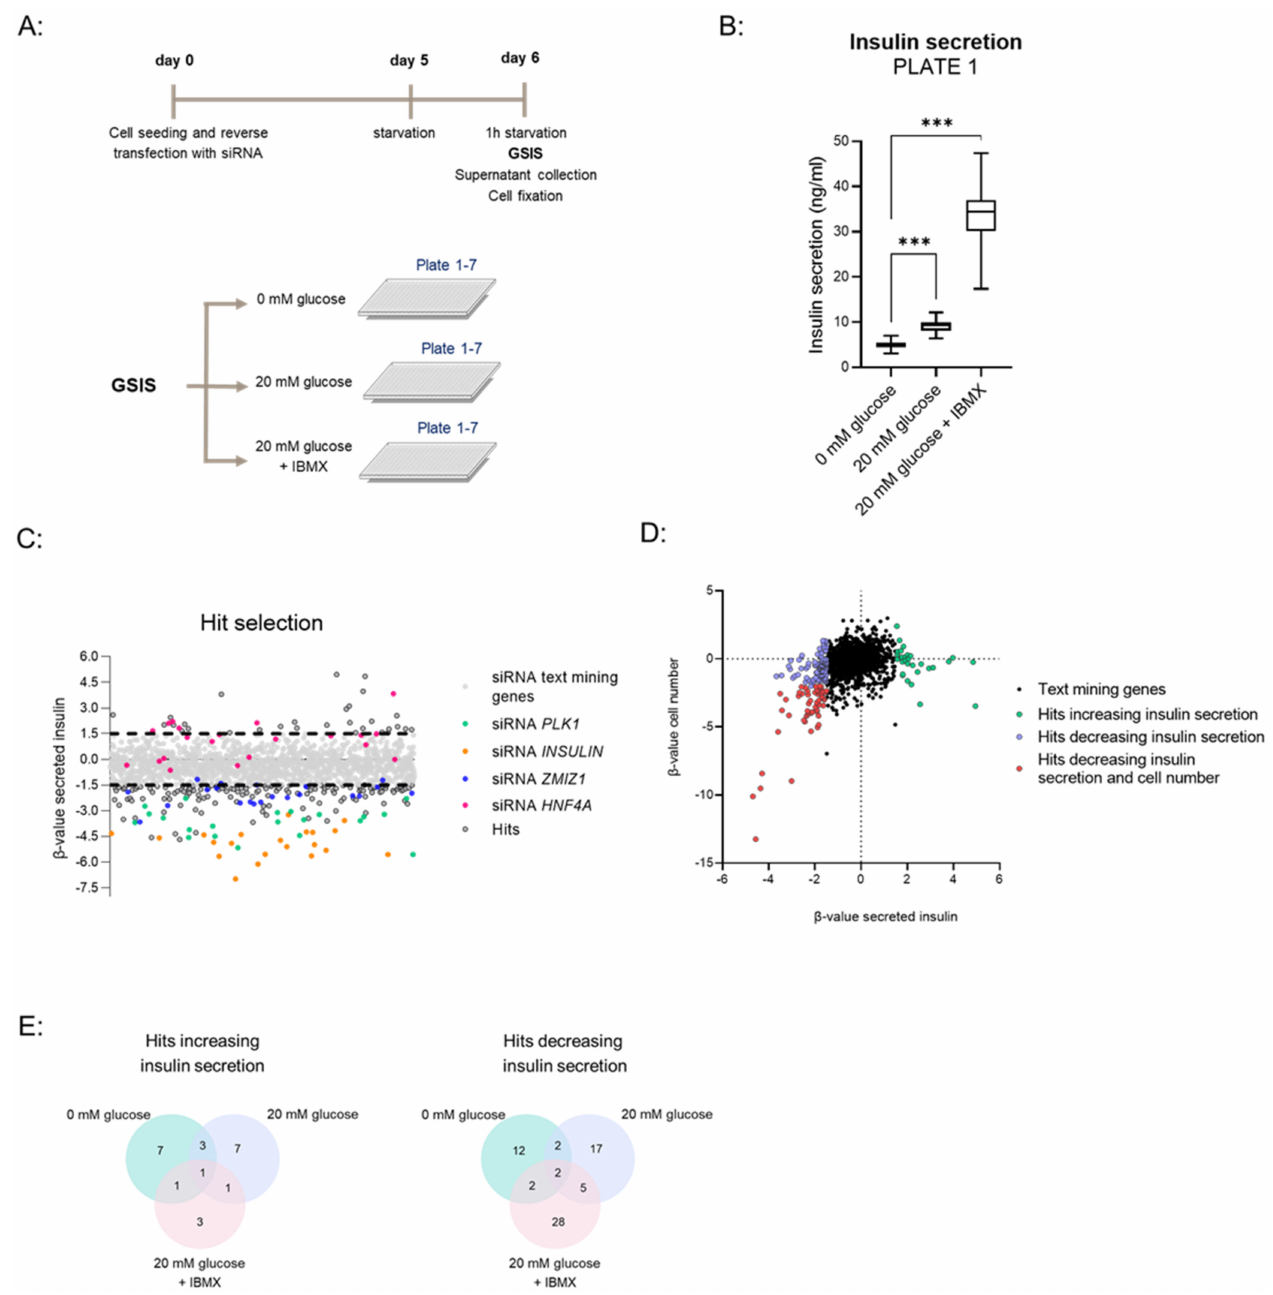
Figure 2. siRNA high-throughput screen in EndoC- β H1 cells with a GSIS readout. ( A ) Simplified workflow of the siRNA screen with GSIS in EndoC- β H1 cells. ( B ) Insulin secretion data for non- targeting control (siRNA NT) for a representative plate (plate 1) in the three tested conditions (0 mM glucose, 20 mM glucose, 20 mM glucose + IBMX). Box plots show min max of n = 33 for siRNA NT for Plate 1. *** p -value < 0.001, one-way ANOVA. ( C ) Dot plot showing β -values of secreted insulin following siRNA treatment across all plates and GSIS conditions. B-values for controls are indicated by colored dots and for hits by grey dots. Black dotted lines denote cut-offs ≥ 1.5 and ≤− 1.5 for hit selection. ( D ) Dot plot of β -value of secreted insulin (x-axis) versus β -value of cell number (y-axis) for text mining genes across all plates and GSIS conditions. Hits increasing, hits decreasing insulin secretion and hits decreasing both insulin secretion and cell number are indicated by different